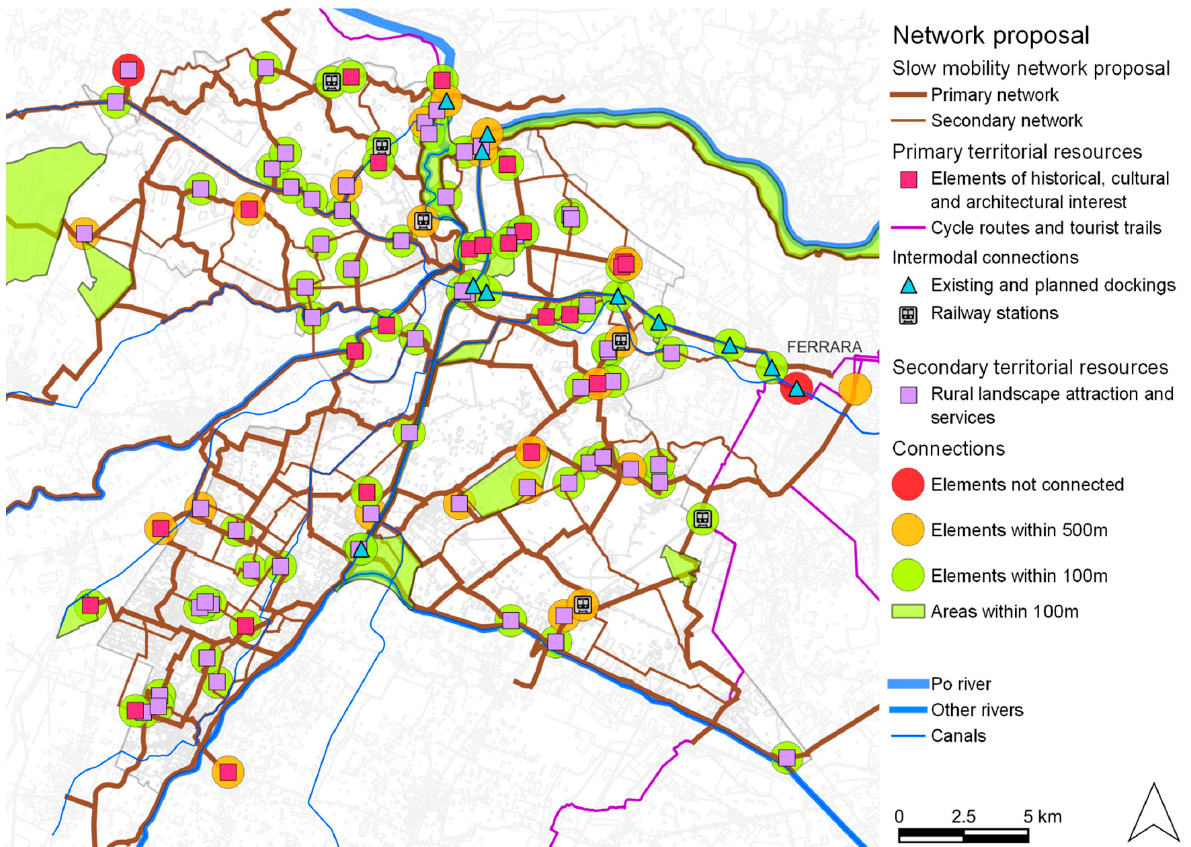
Figure 9. Connection capacity of proposed soft mobility network.